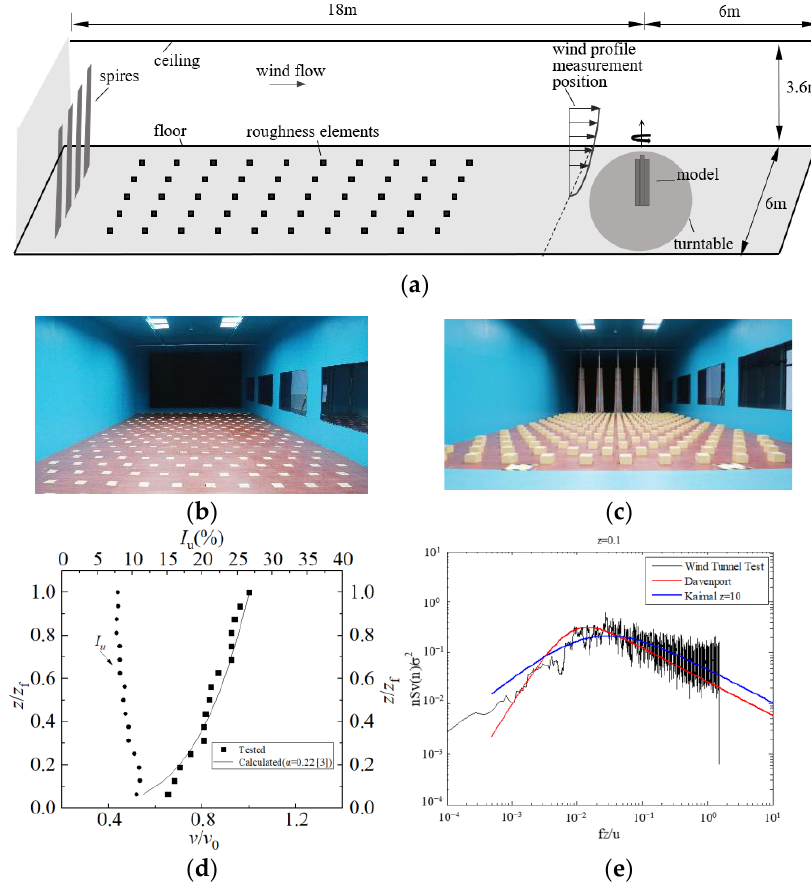
Figure 2. Wind fields in the wind tunnel : ( a ) Schematic diagram of the wind tunnel ( b ) uniform inflow condition in the wind tunnel without rough elements or wedges; ( c ) atmospheric boundary layer flow condition in the wind tunnel with rough elements and wedges; ( d ) wind speed profile and the turbulence intensity profile in the wind tunnel; ( e ) turbulent wind power spectrum of the incoming flow in the wind tunnel.